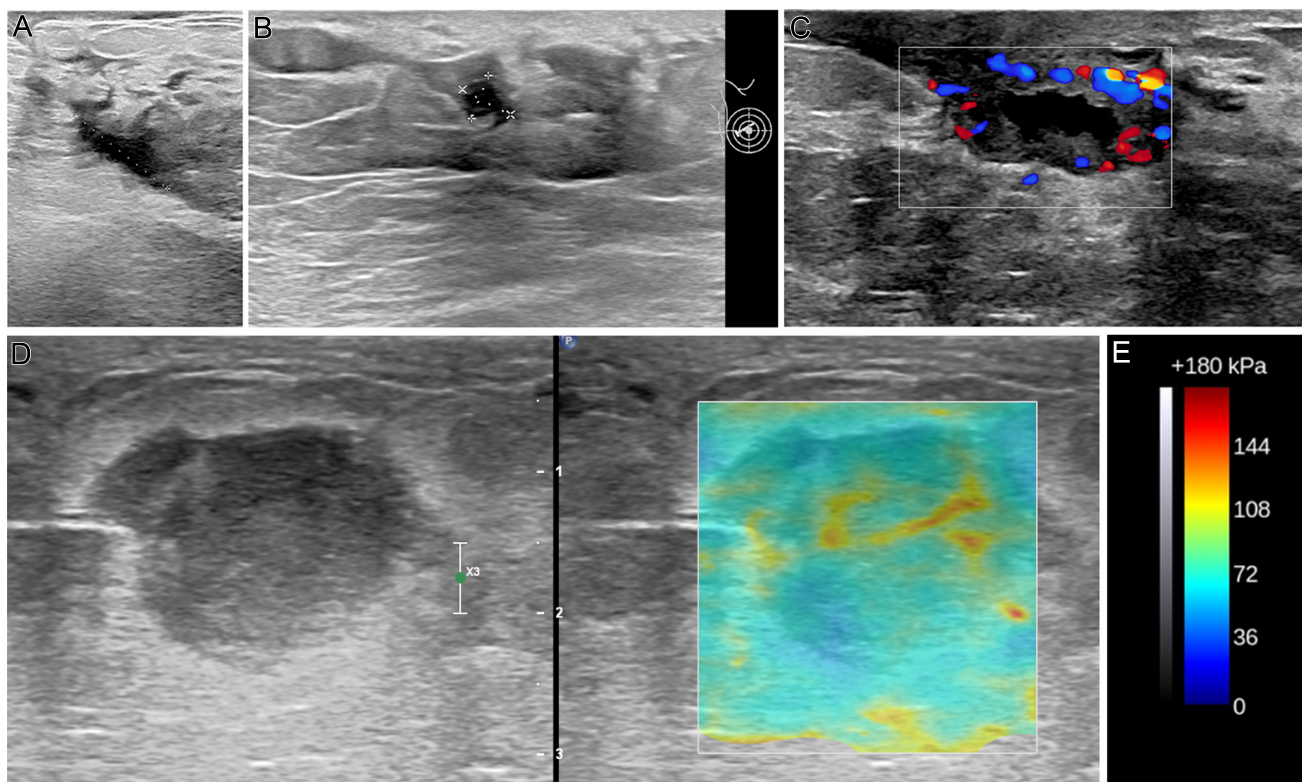
Figure 2. A-E. Targeted ultrasound images from (A) through (D) depicting different grades of idiopathic granulomatous mastitis (IGM) on different patients. (A) A fistula tract shows the drainage of purulent content on the background B-mode image and color Doppler map displays ongoing hyperemia within the wall of the tract. This finding corresponds to Grade II. (B) Hypoechoic solid-like mass measuring about 3.4 cm on long axis with diffuse increment on echogenicity of surrounding tissue obtained at gray-scale ultrasound at 9 o’clock position of the right breast in a 28-year-old postpartum woman presenting with denial of breastfeeding by her baby on the affected breast. Following 3 weeks of conservative treatment due to a lack of symptom resolution with progression in the size of the lesion, a biopsy was performed, and the result was IGM. This lesion demonstrates the earliest course of disease initiation and corresponds to grade I. (C) In another patient with a history of periductal mastitis on the contralateral breast prior 2.5 years was referred to the tertiary university hospital for further work-up of the lesion on the right side. The abscess formation (measurement markers) is clearly depicted within the extremely IGM-involved periareolar breast side. These findings correspond to grade III. (D) Elastosonographic image of the biopsy-proven IGM lesion. Color box (E) indicates the stiffness of tissue based on elasticity properties of the region of interest with red depicting the hardest and blue the